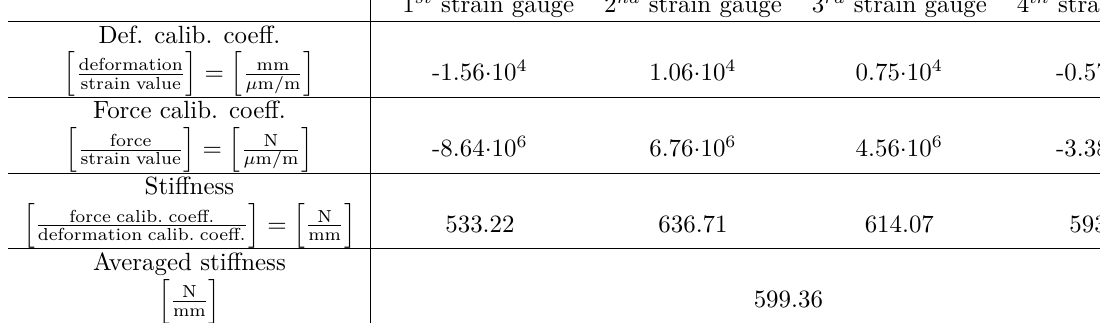
Table 1. Calibration coefficients and the calculated stiffness.